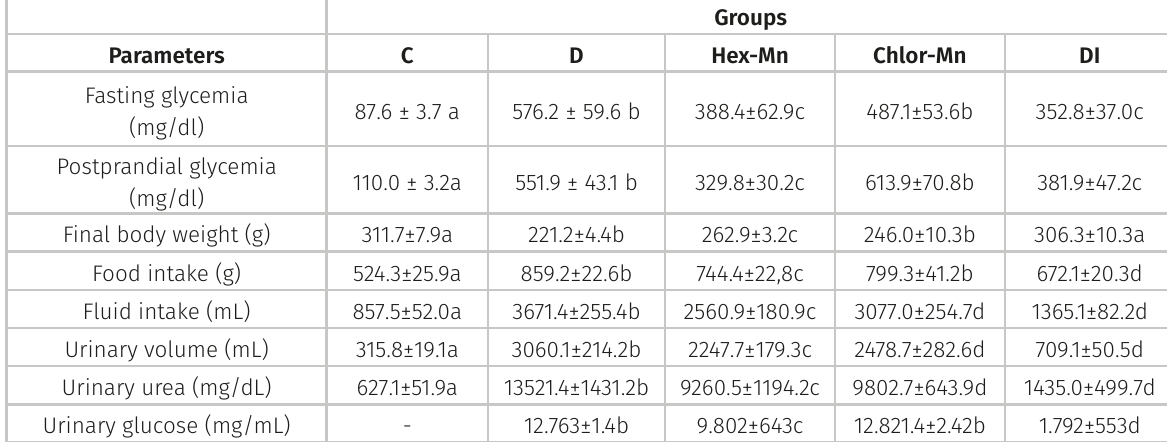
Table I. Fasting and postprandial glucose at 21 day of treatment and accumulative effects of Hex-Mn and Chlor- Mn fractions on body weight gain, food and fluid intake, urinary volume, glucose, and urea urinary in control and diabetic treated for 21